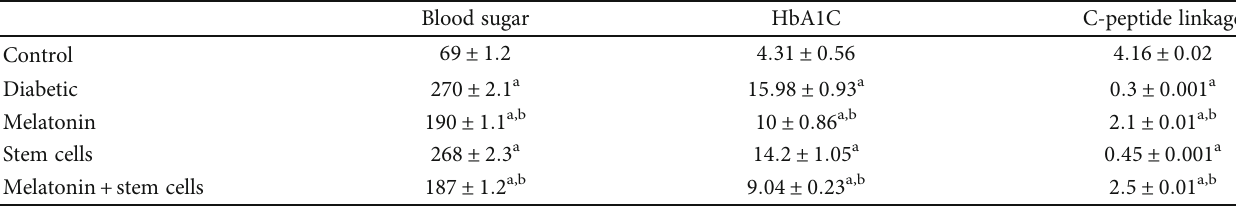
Table 1: Changes in the blood glucose pro fi le in di ff erent treated